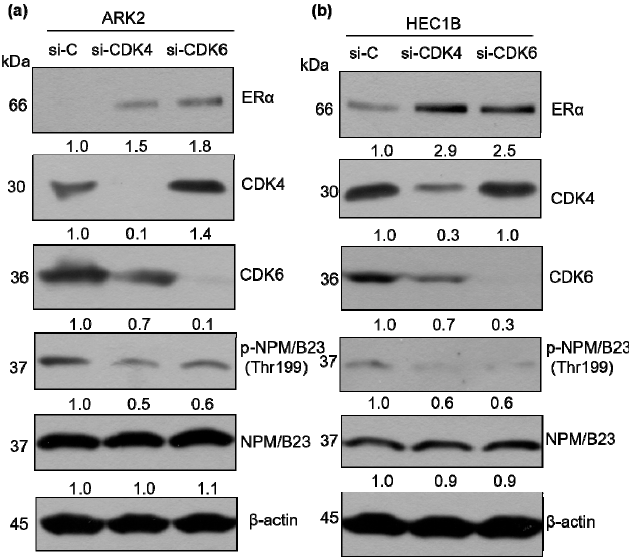
Figure 4. CDK6-mediated phosphorylation of NPM / B23 promotes ER α expression. ( a , b ) ARK2 or HEC1B cells were transiently transfected with control siRNA (si-C), CDK4 siRNA (si-CDK4), or CDK6 siRNA (si-CDK6) for 72 h. Cell lysates were subjected to western blot using antibodies raised against ER α , CDK4, CDK6, phospho-NPM / B23 (Thr199), NPM / B23, and β -actin. Densitometry-derived values (bottom) are normalized with the control (si-C), which was set as 1. Data shown are derived from three independent experiments. β -actin serves as the loading control for